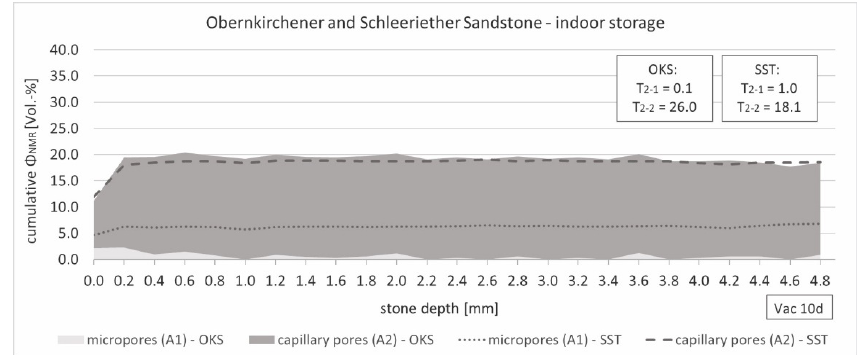
Figure 7. Fitted and stacked relaxation depth profiles of unweathered Obernkirchener and Schleer- ither Sandstone samples saturated under vacuum (0.05 bar).